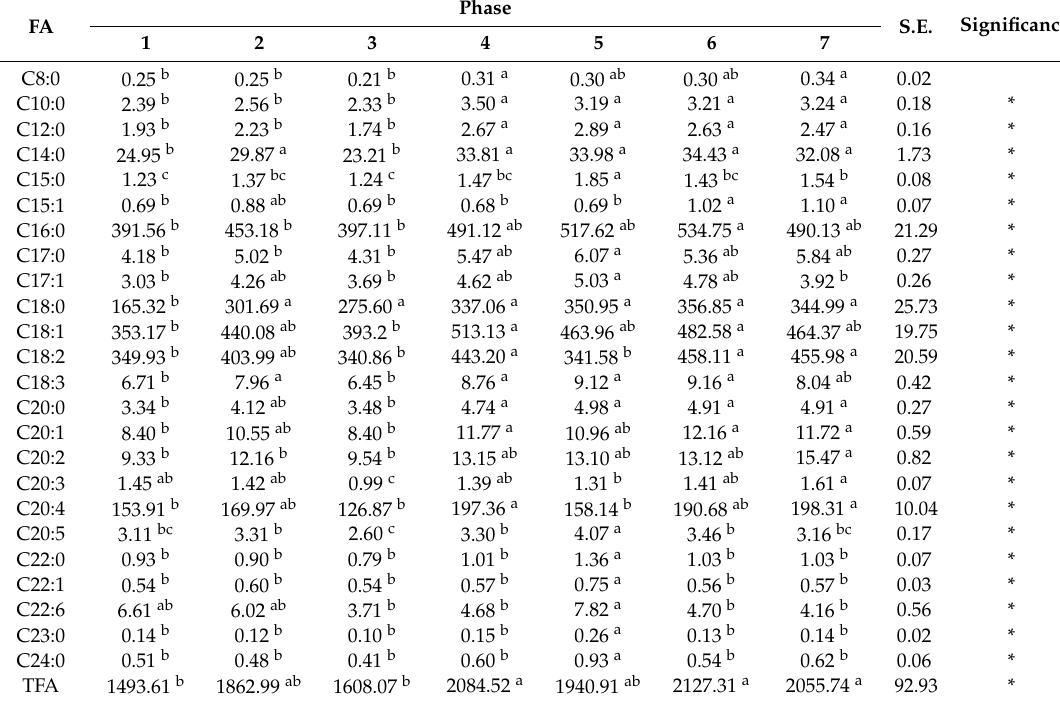
s.e. Significance